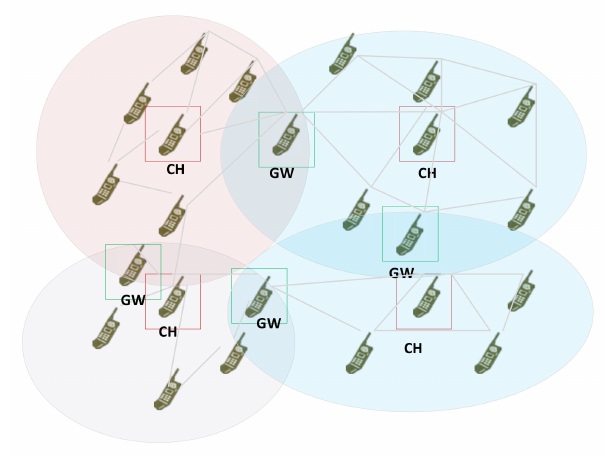
Figure 3. Cluster